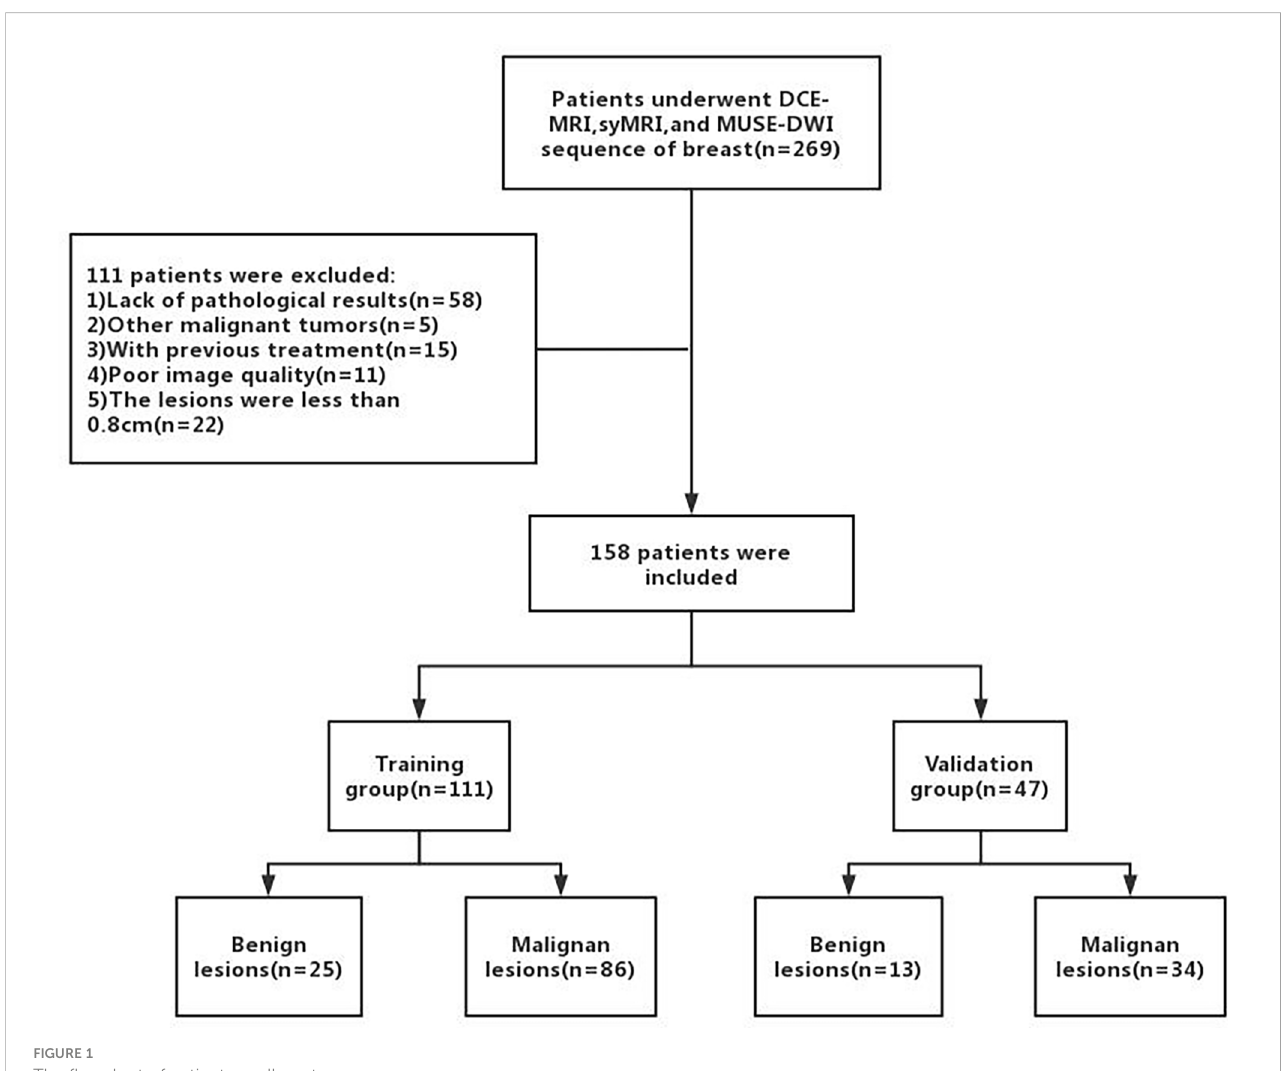
FIGURE 1 The fl owchart of patient